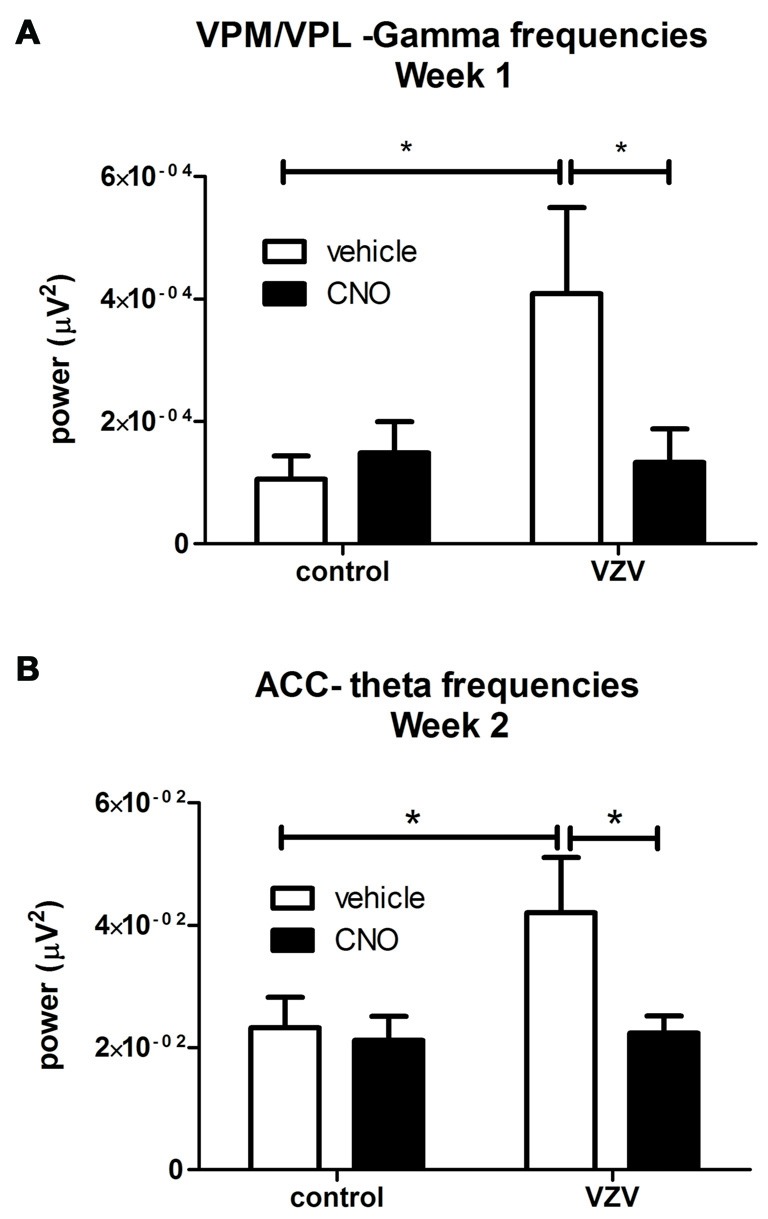
Experiment 3, power spectrum analysis following infusion of the VPM/VPL thalamus with AAV8-hSyn-hM4D(Gi)-mCherry and placement of an electrode in the anterior cingulate cortex (ACC) and VPM/VPL VZV was injected into the whisker pad 1 week after surgery. Local field potential (LFP) recordings were completed in the VPM/VPL (A) and ACC (B). Thirty minutes before LFP recording the rats were given an injection of either CNO or vehicle (0.9% saline). Testing was completed once a week for 30 min. Testing was performed on three consecutive weeks. Data for week 1 is shown in (A) and the data for week 2 is shown in (B); data for week 3 was not significant and is not shown. Asterisk indicates a significant difference of p < 0.05. There were seven animals in each treatment group. The values are the mean ± SEM.